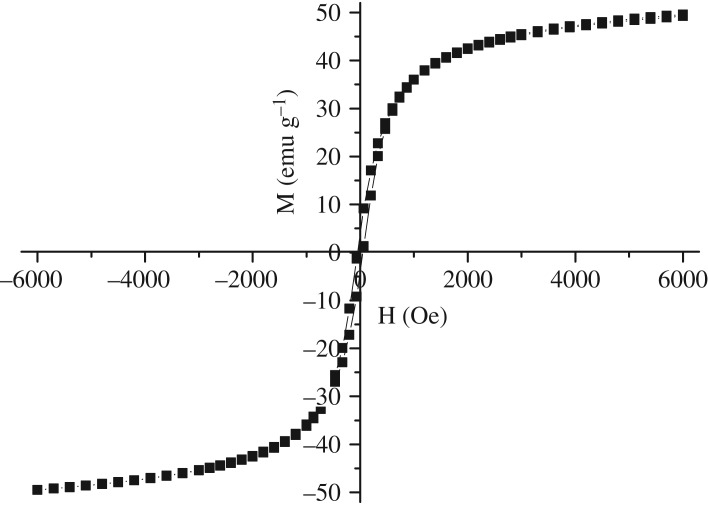
Magnetic hysteresis curve for Fe3O4 sample.